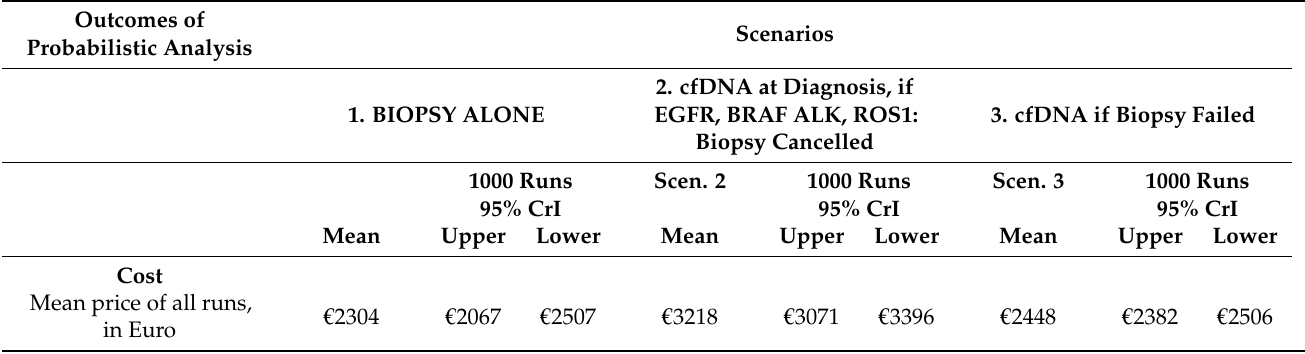
Table 2. Results of the probabilistic sensitivity analysis: mean results of 1000 runs per scenario, pre- sented with 95% quantiles.